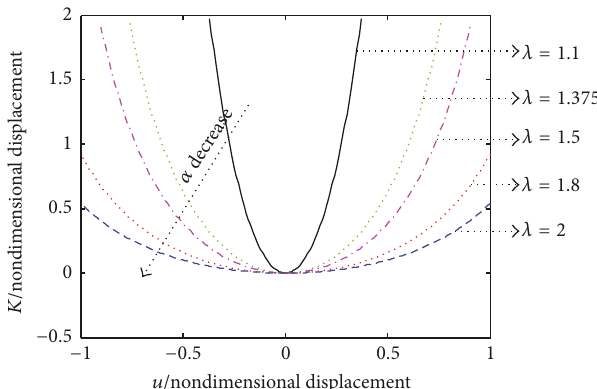
Figure 7: Nondimensional displacement stiffness for a parameter.